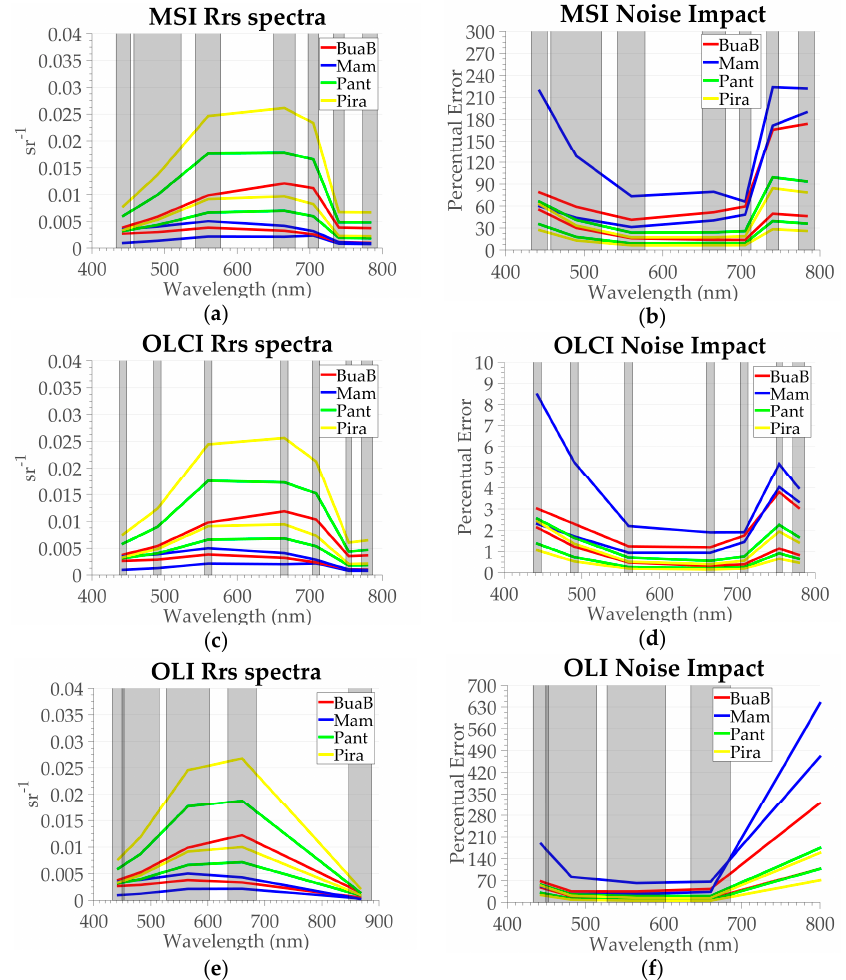
Figure 4. ( a – f ) Noise band-weighted R rs spectra for each sensor ( a , c , e ) and normalized error due to the optical characteristics of each sensor band ( b , d , f ), with two spectra of each lake. ( a , b ) MSI; ( c , d ) OLCI; ( e , f ) OLI. Each lake is represented by a specific color; Mamirauá in Blue, Bua-Buá in red, Pantaleão in green, and Pirarara in yellow. The noise used was equal to (cid:3013) (cid:3269)(cid:3264)(cid:3250) (cid:3020)(cid:3015)(cid:3019) × . rnd , in which rnd is the standard deviation of a standard normal distribution (equal to 1). The percent error is equal to 100 × (cid:3019) (cid:3293)(cid:3294) ((cid:3041)(cid:3042)(cid:3036)(cid:3046)(cid:3052))(cid:2879)(cid:3019) (cid:3293)(cid:3294) . (cid:3019) (cid:3293)(cid:3294)